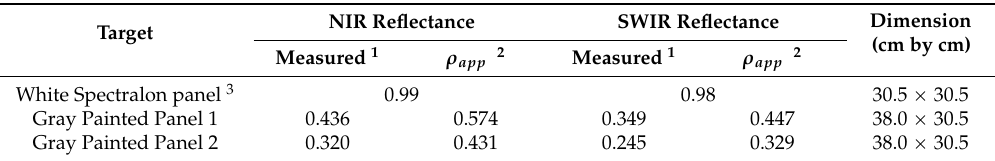
Table 2. Reflectance values of panels used in calibration.